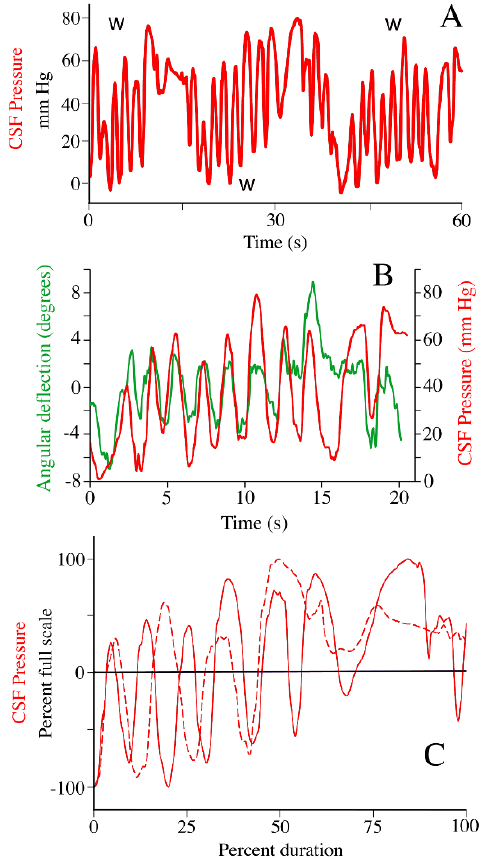
Figure 12. The influence of locomotion on CSF pressure in Alligator mississippiensis . Unrestrained animals were previously trained to walk on the treadmill; these data tracings were all taken after the animal was recovered enough from surgery to perform sustained locomotion. ( A ) CSF pressure traces (red) from an unrestrained alligator locomoting on a treadmill, the periods of sustained locomotion (denoted by W) are characterized by large amplitude sinusoidal waves of CSF pressure. ( B ) close temporal congruence between angular displacement of the head (green) and CSF pressure (red) during locomotion. ( C ) two locomotor CSF traces graphed as percent CSF pressure; note that the CSF pressure increases over the course of the locomotor sequence so that the pressures are above average (black horizontal line) at the end of the sequence.